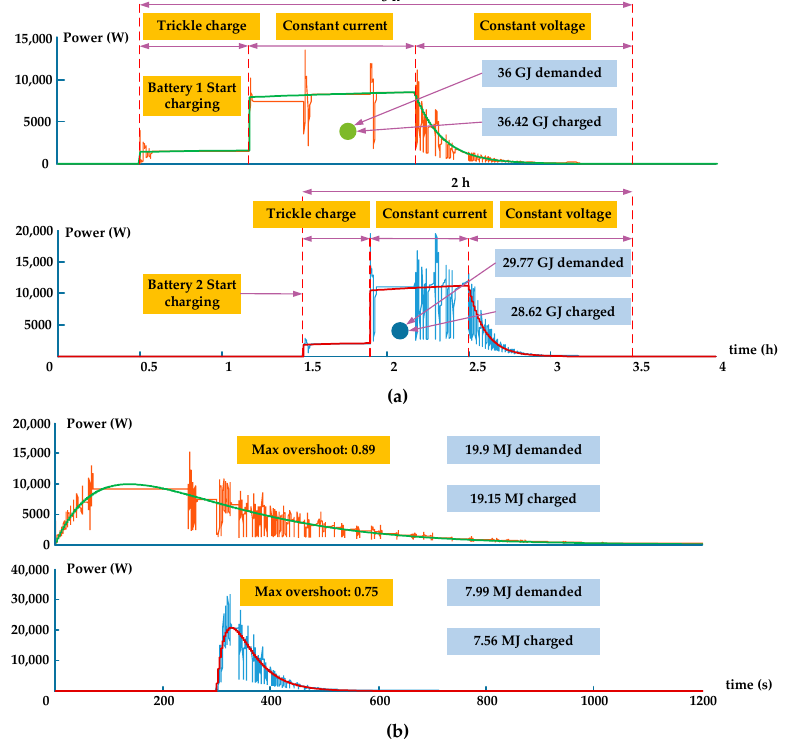
Figure 10. Charging procedure of batteries and super capacitors. ( a ) Charging procedure of batteries. ( b ) Charging procedure of super capacitors. Figure 10b depicts the charging procedure of two super capacitors. Power demand varies continuously. Maximum overshoot of super capacitor 1 and super capacitor 2 equals 0.89 and 0.75 respectively. Total demanded energy and charged energy of super capacitor 1 and super capacitor 2 equals 19.9 MJ, 19.15 MJ, 7.99 MJ and 7.56 MJ, respectively. The energy accuracy is in the range of